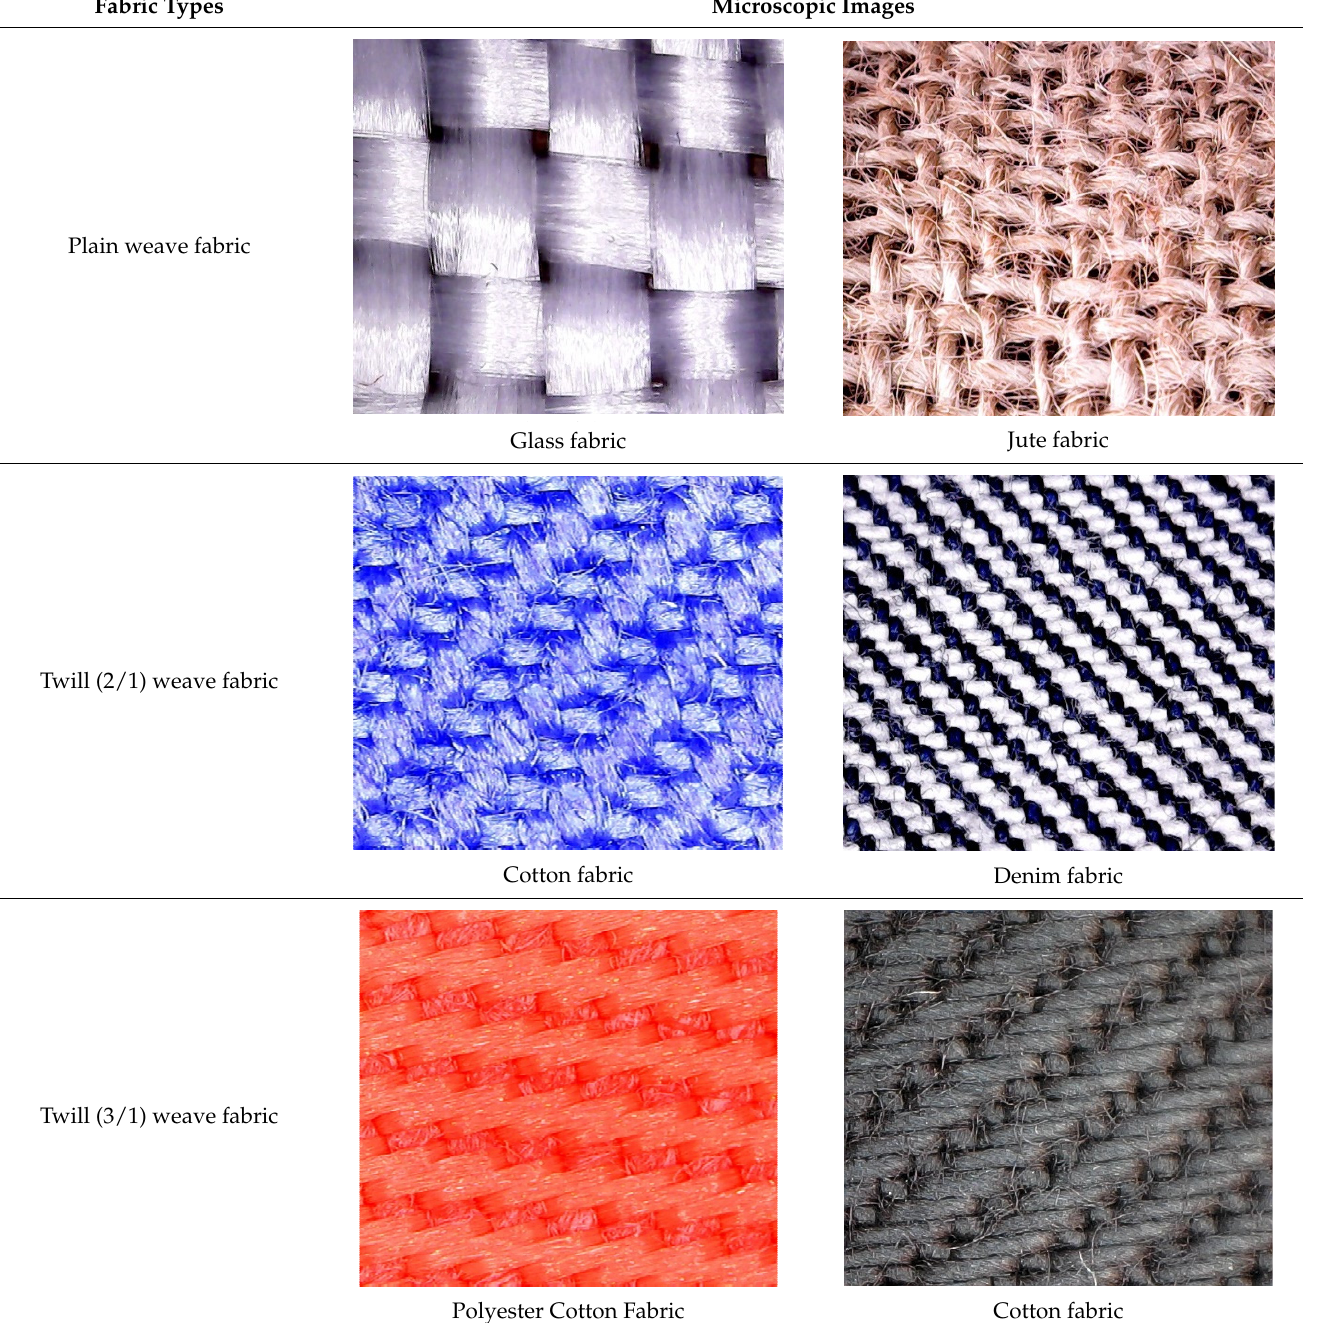
Table 6. Fabric types of tested textile specimen.